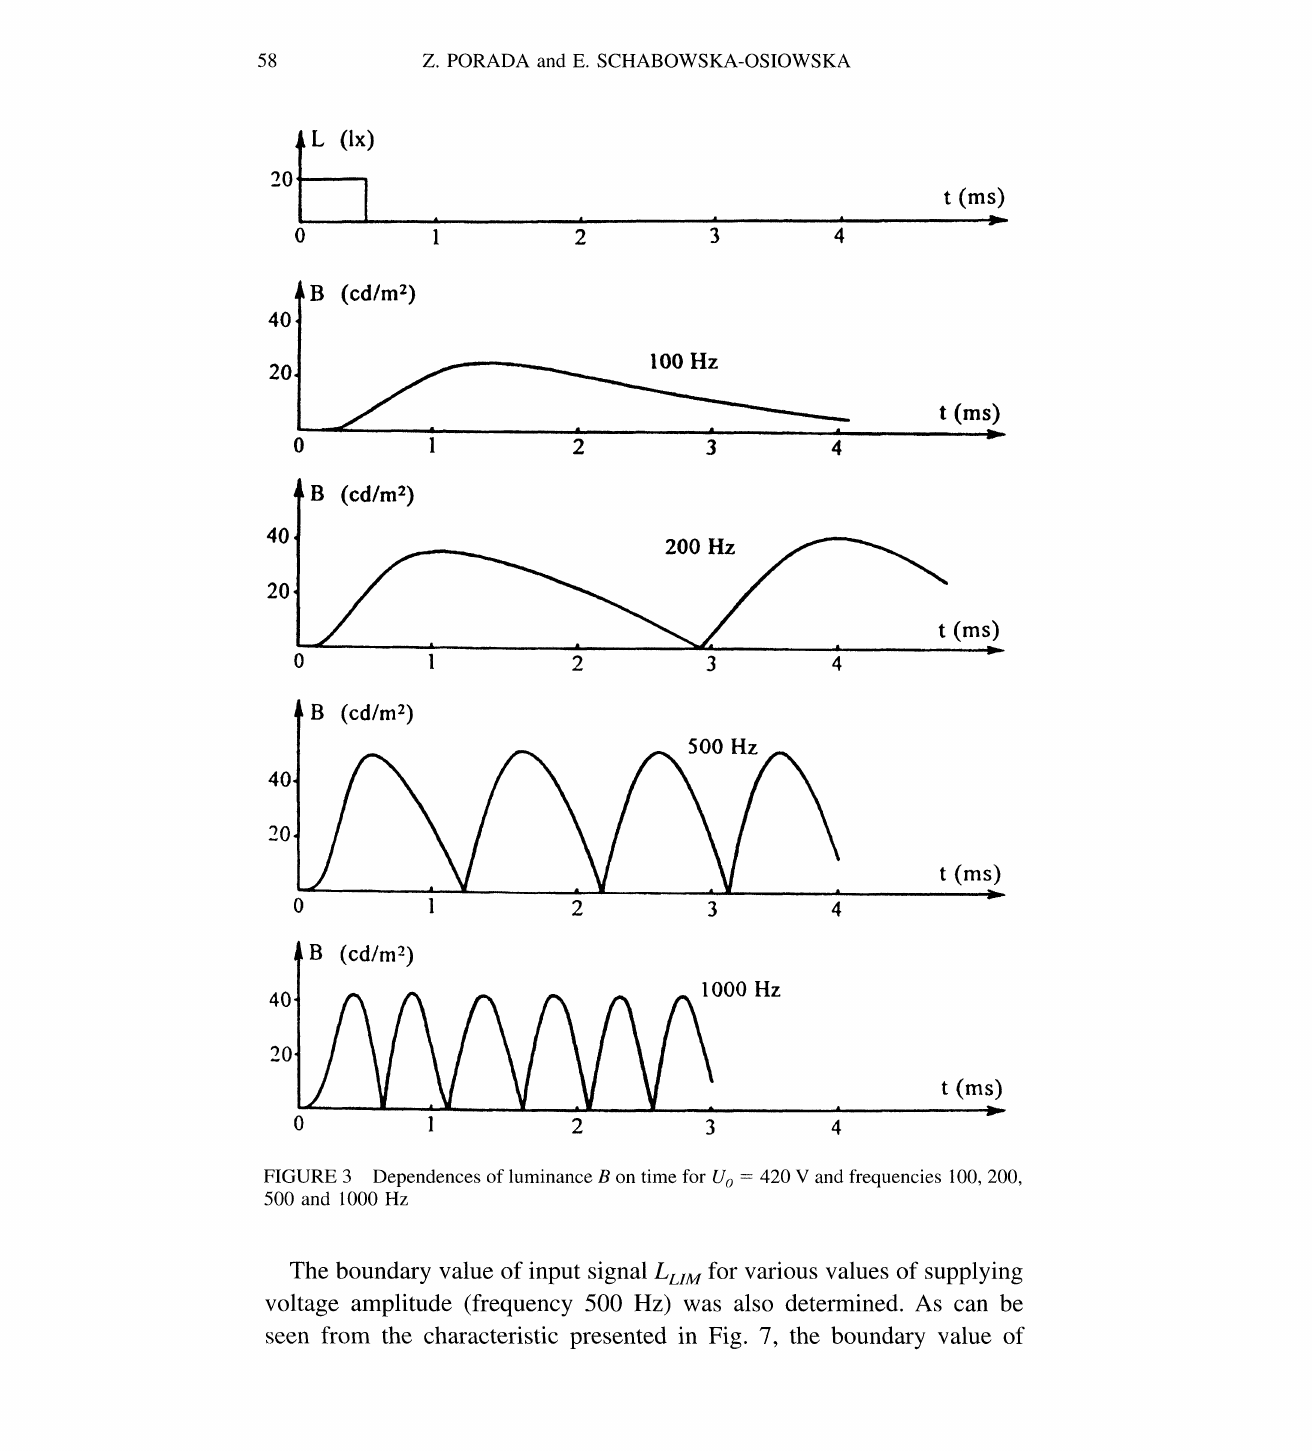
FIGURE 3 Dependences of luminance B on time for U 420 V and frequencies 100, 200, 500 and 1000